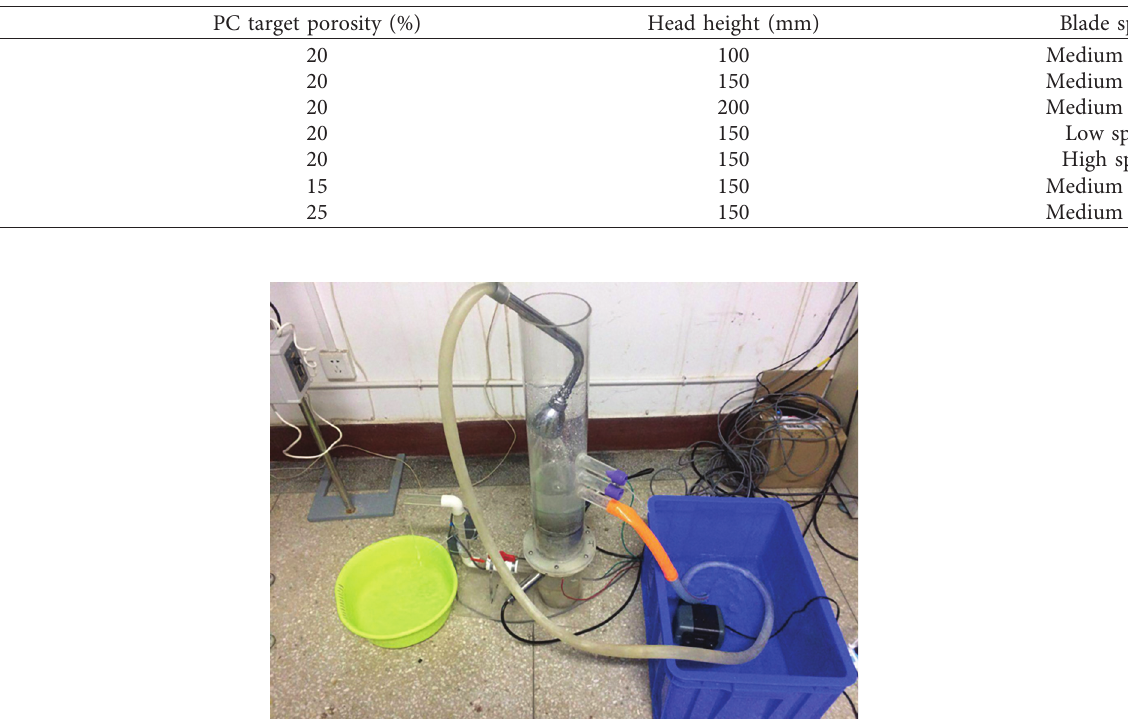
Table 8: Test plan.